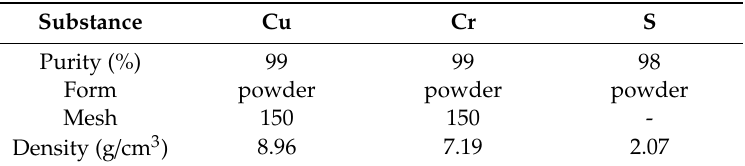
Table 1. (Non)metallic material properties.